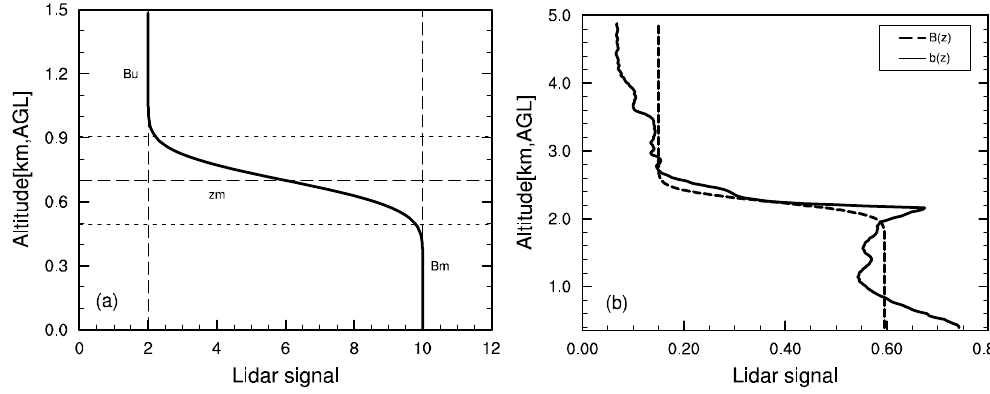
Figure 2. ( a ) An idealized backscatter profile, and ( b ) a real case for the curve fitting procedure. Both HM and CFM are easily affected by the cloud layers, RL, and local signal structure. To eliminate the interference of RL and cloud layers, this study determined a top limiter altitude below which the ABLH was retrieved. In addition, the influences of the local signal structures, such as that caused by the advection aerosol layer, were also controlled through consideration of the temporal continuity. The detailed procedures are described in the following section.